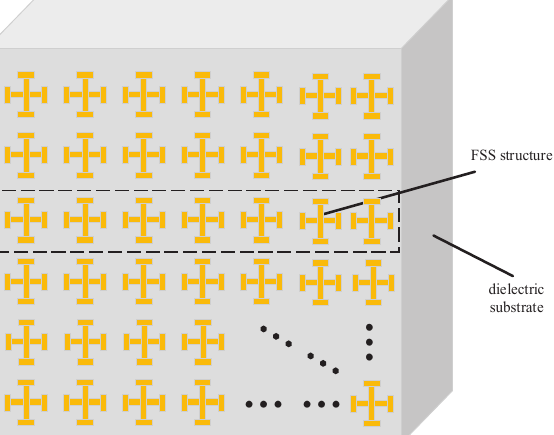
Figure 1. Geometry of the proposed 101 × 101 metasurface lens.